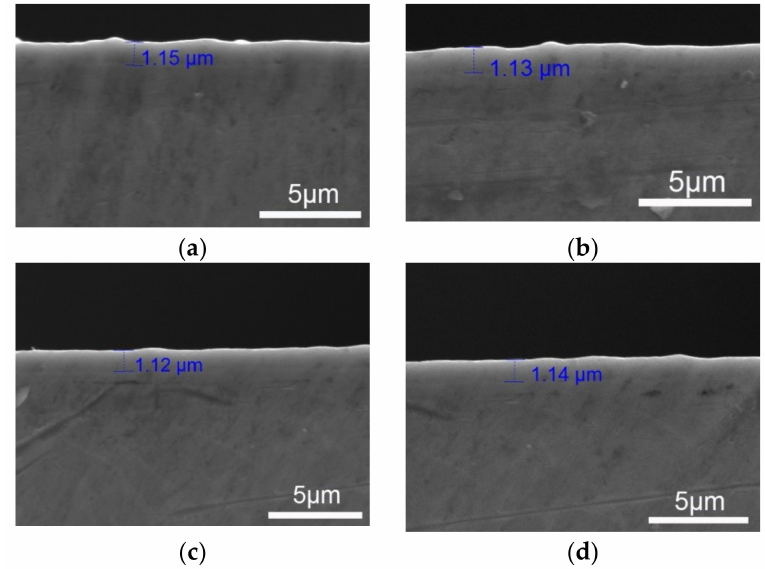
Figure 4. Thickness uniformity investigation of the TiN coating at four areas 90 ◦ apart on the middle cross-section face perpendicular to the axial of the specimen. ( a ) 0 ◦ ; ( b ) 90 ◦ ; ( c ) 180 ◦ ; ( d ) 270 ◦